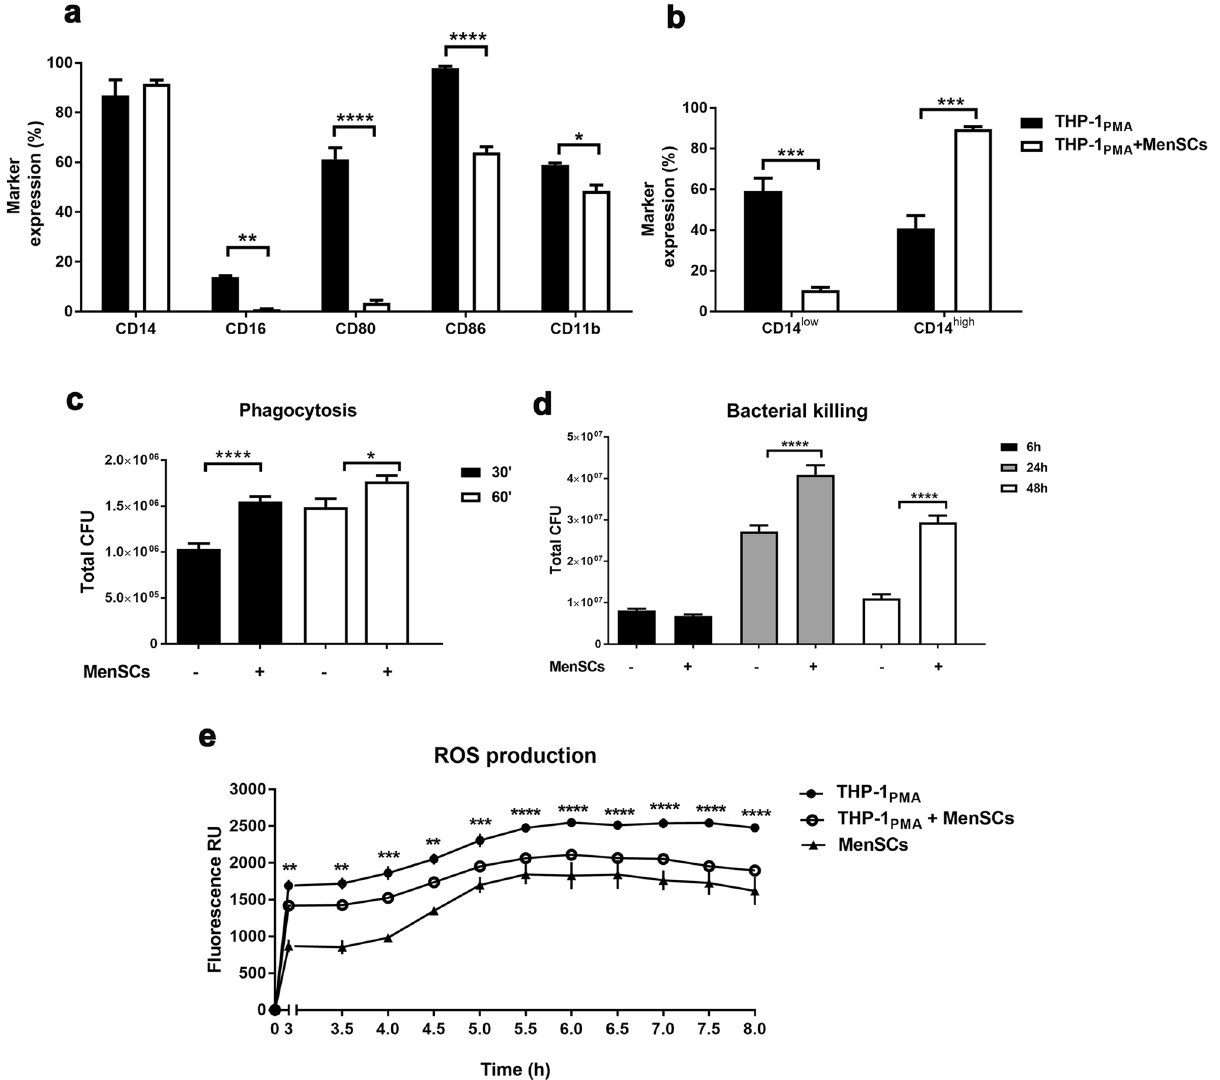
Figure 4. Evaluation of the activity of PMA-differentiated THP-1 cells co-cultured with MenSCs. PMA- differentiated THP-1 cells (THP-1 PMA ) were co-cultured or not with MenSCs (ratio 4:1) for 48 h ( c – e ) or 72 h ( a,b ). ( a ) Phenotypic characterisation and ( b ) CD14 specific expression pattern of THP-1 PMA . ( c ) THP-1 PMA intake of Salmonella SseB − after 30 min and 60 min of bacteria exposure. ( d ) Gentamicin protection assay reflecting bacteria killing time lapse of THP-1 PMA after exposure to Salmonella SseB − for 60 min. ( e ) ROS production in vitro was measured by DCFDA oxidation. Results are represented as mean ± SEM of 3–6 different MenSCs, derived from different donors (n = 3–10 replicates). *p < 0.05, **p < 0.01, ***p < 0.001, ****p < 0.0001. RU relative units, CFU colony-forming